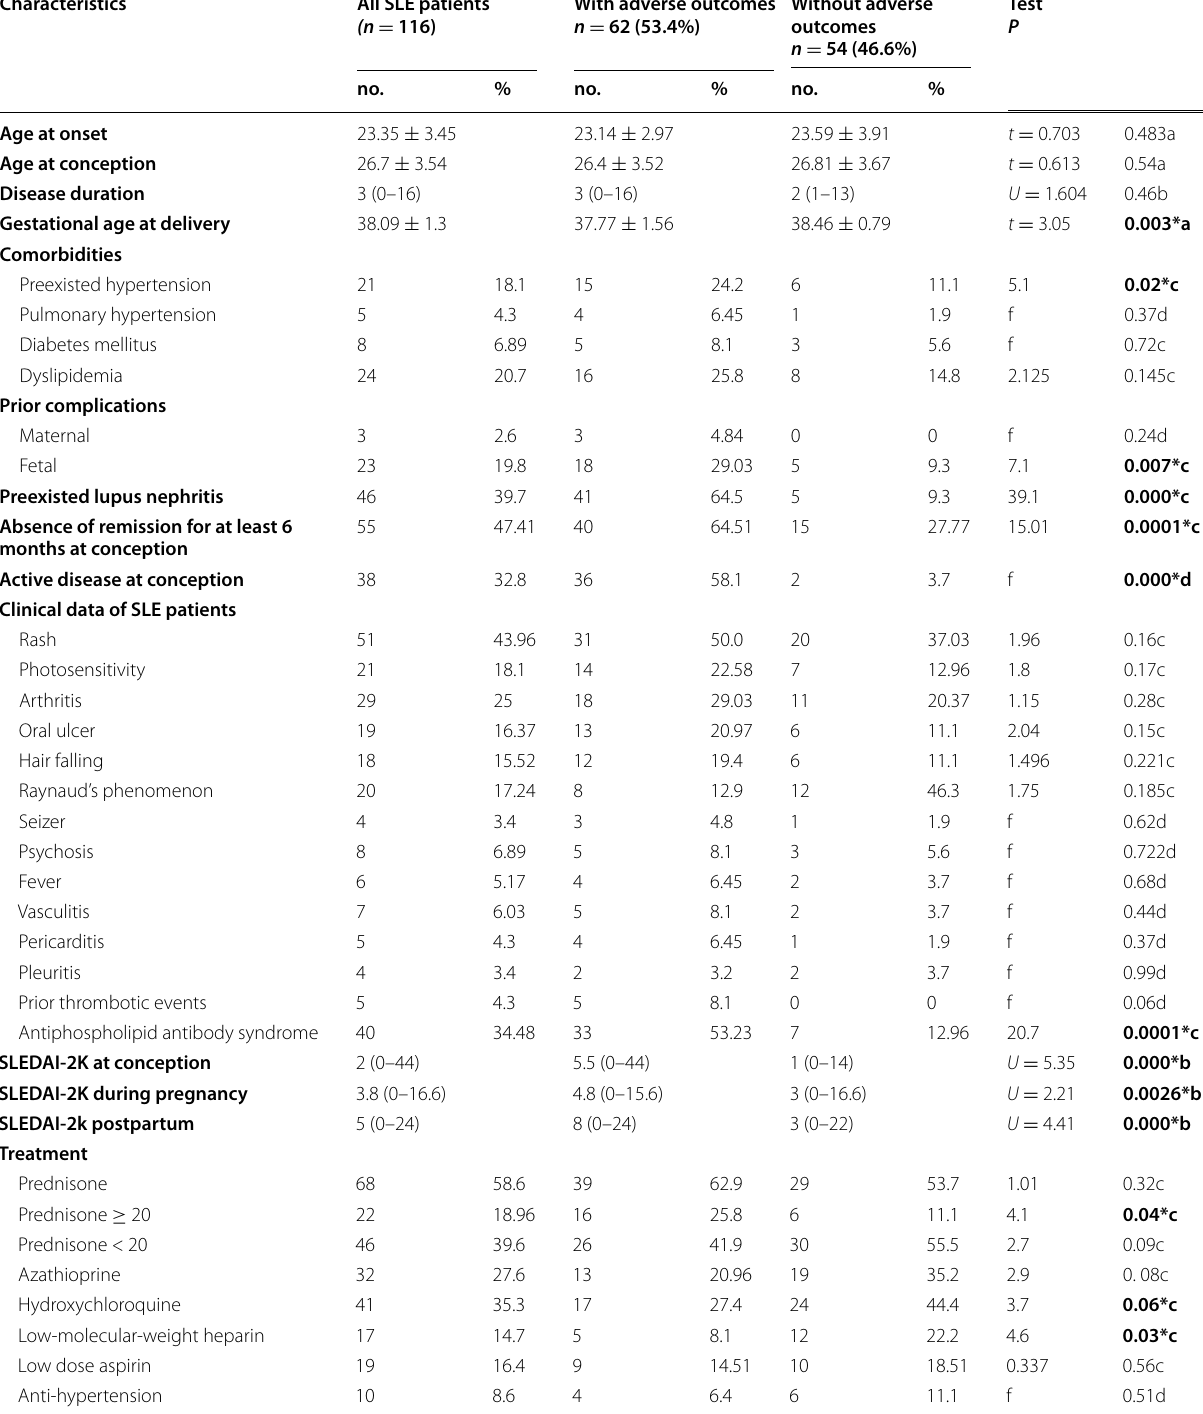
SLE systemic lupus erythematosus. All values are presented as mean test, d Fisher test, SLEDAI systemic lupus erythematosus disease activity index. Insignificant, P > 0.05; significant, * P